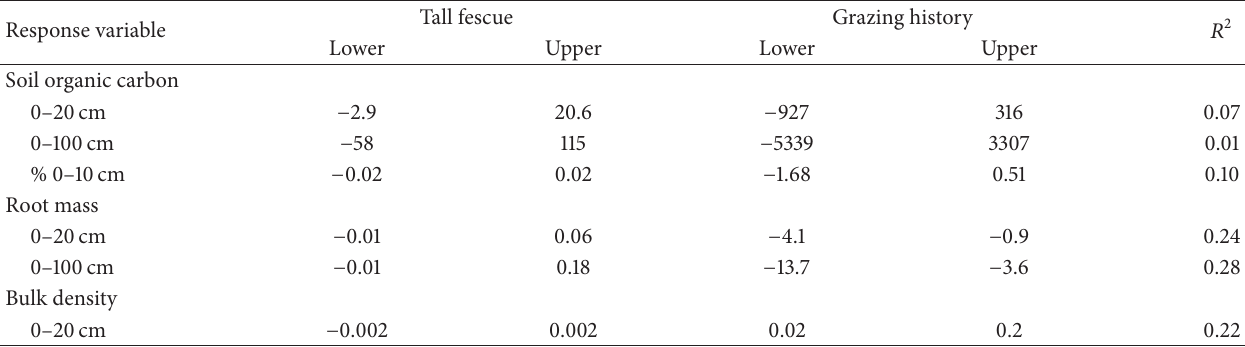
Table 3: Results of six multiple linear mixed effect regression models each comparing response variables against tall fescue abundance and grazing history as independent variables (fixed effects). Lower and upper bounds define simulated 95% confidence intervals while 𝑅 2 reports goodness-of-fit for multiple fixed effects.